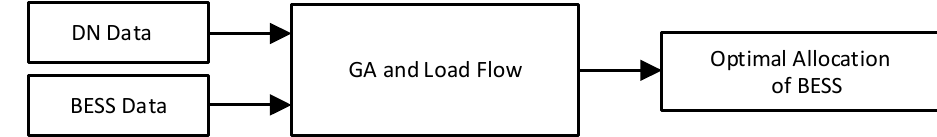
Figure 5. Illustration of GA utilization to find BESS optimal allocation.